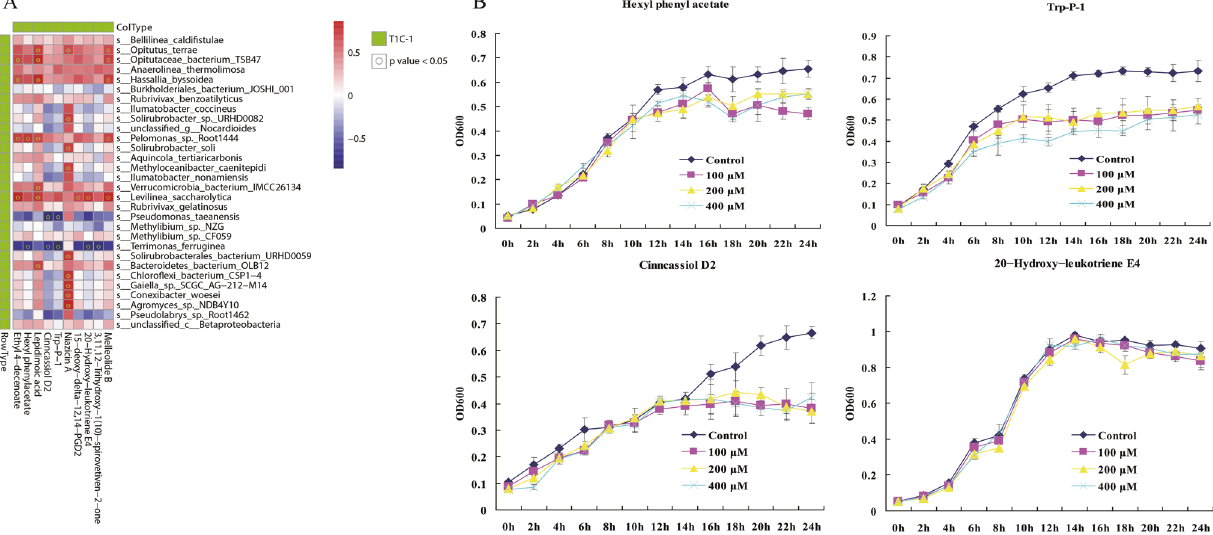
Fig. 7 Associations between T1C-1-representative root exudate metabolites and microbial taxa. Associations between representative root exudate metabolites of Bt rice and microbial species ( A ) and validation of four predicted metabolite-microorganism relationships ( B ).